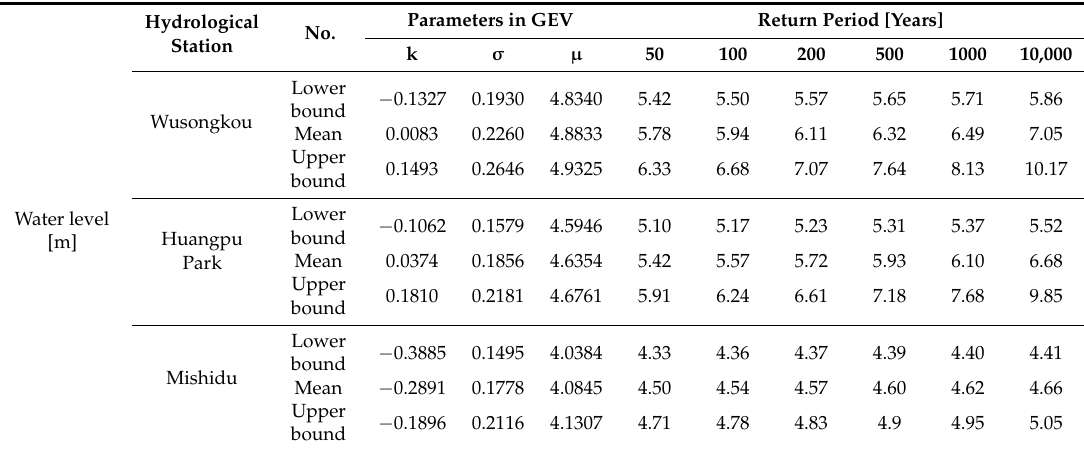
Table 4. Results of the parameter estimation for GEV and water levels as a function of return periods at three hydrological stations, with 95% confidence